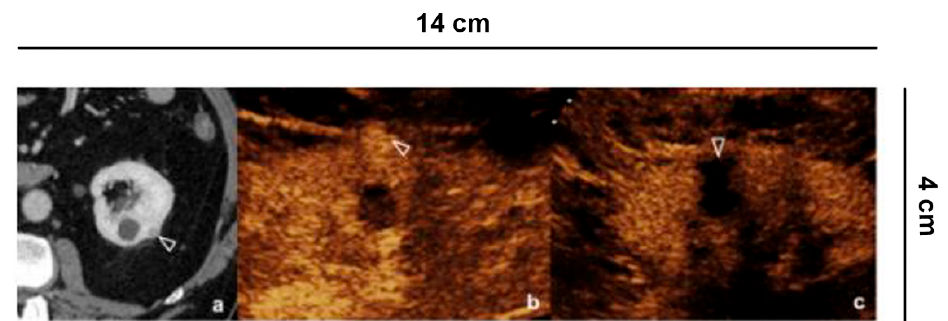
Figure 5. Follow up of microwave tumor ablation. ( a ) CECT shows a small renal lesion, partially exophytic, adjacent to a simple cyst, in the middle third of the left kidney; ( b ) Before the microwave treatment CEUS evidences a hyper-vascular, partially exophytic lesion (arrowheads); ( c ) After 12 h from the microwave ablation, CEUS shows an avascular area without recognizing the lesion (arrowheads), a sign of treatment success.